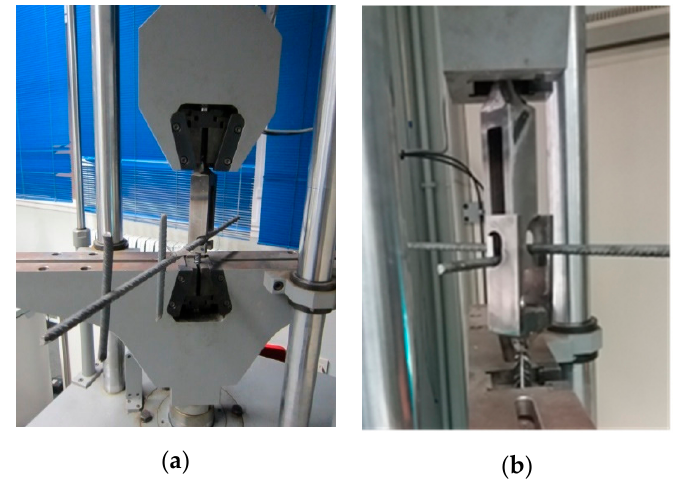
Figure 8. Shear ( a ) and tensile ( b ) failure tests.